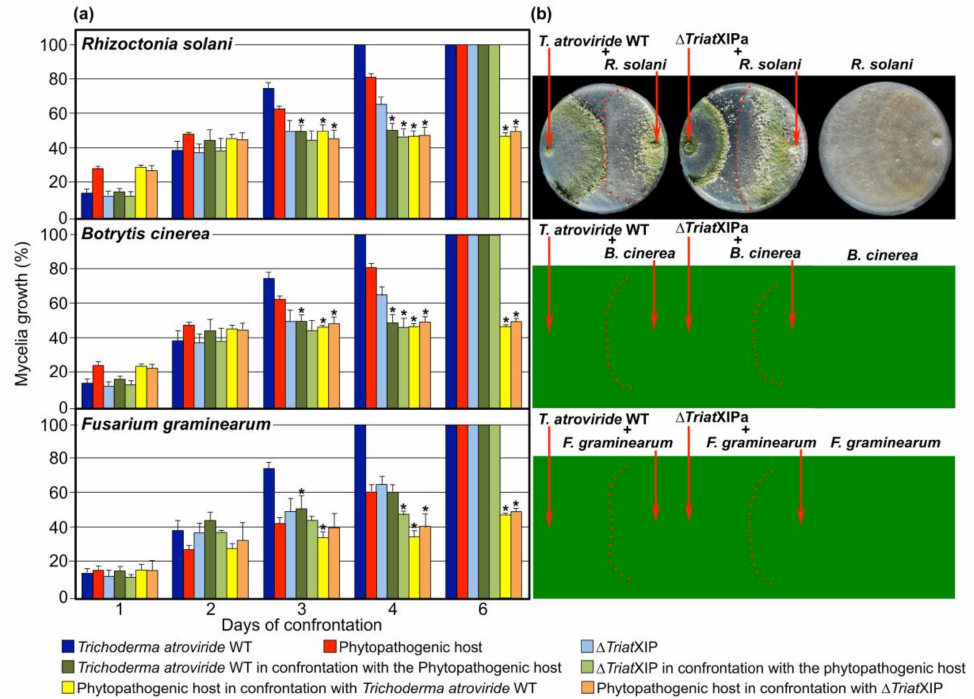
Figure 4. Mycoparasitic activity of the five ∆ Triat XIP mutants and T. atroviride wild strain against Rhi- zoctonia solani , Botrytis cinerea and Fusarium graminearum as phytopathogenic hosts. ( a ) The mycelial growths on PDA medium correspond to the mean of three independent biological experiments, and bars represent the biological standard deviation. *, Data of the five ∆ Triat XIP growth rates, and each wild strain (antagonist and phytopathogenic hosts) placed in confrontation situations were statistically and significantly different from that of each strain upon stress-free cultivation at the corresponding time point, as verified by one-way ANOVA analysis followed by Tukey’s post hoc test ( p < 0.05). Statistical calculations carried out included ( T. atroviride WT + Host WT vs. T. atroviride WT), ( ∆ Triat XIPs + Host WT vs. ∆ Triat XIPs), (Host WT + T. atroviride WT vs. Host WT), and (Host WT + ∆ Triat XIPs vs. Host WT). ( b ) Plate confrontation assays of the T. atroviride parental strain (first plate) and the ∆ Triat XIPa mutant (second plate; ∆ Triat XIPa is used for illustration, all confrontations implicating the five ∆ Triat XIPs are presented in Figure S11, and the phytopathogenic hosts (third plate). Pictures were taken six days after inoculation of the two fungi on opposite sides of the